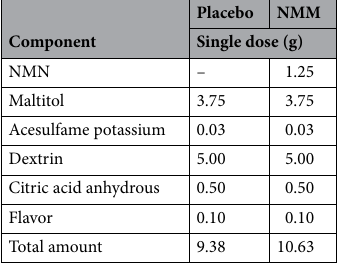
Table 1. Composition of the test foods.